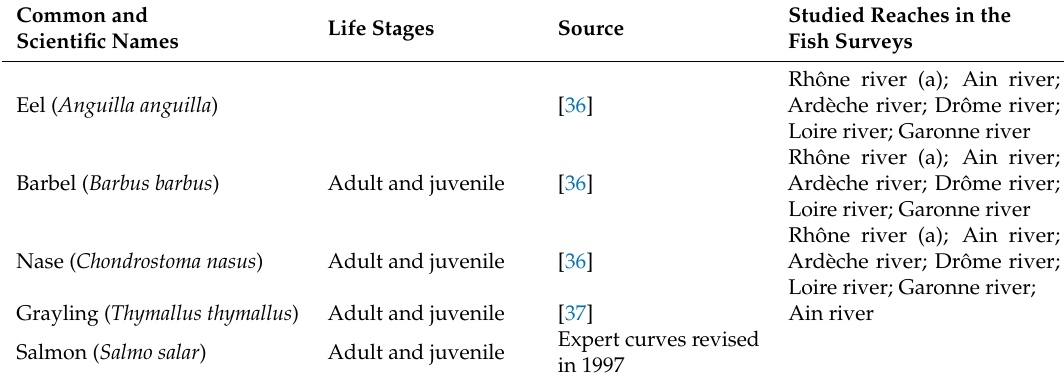
Table 1. References for the suitability curves used in this study for each native fish. (a) indicates studies devoted to by-passed